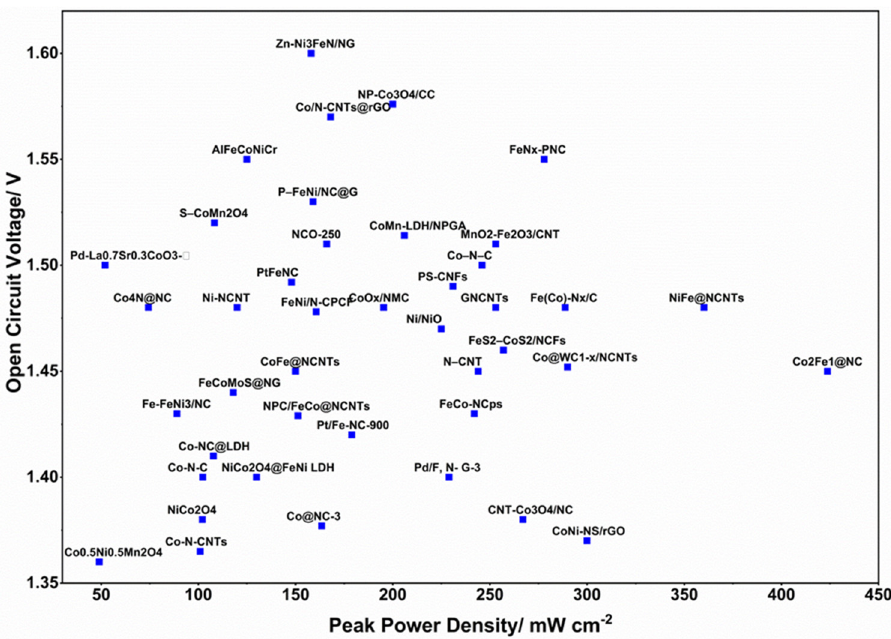
Figure 8. Open ‐ circuit voltage and peak power density of ZABs employing different